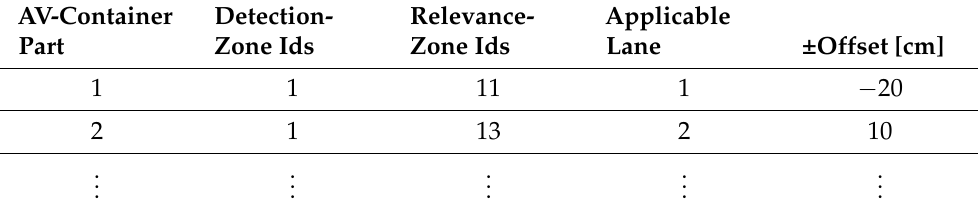
Table 2. IVIM lane off-set messages information